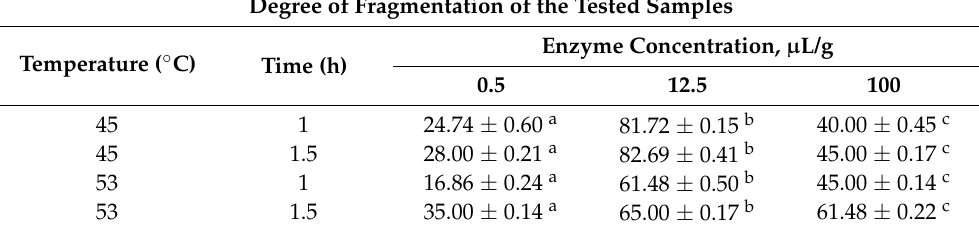
Table 1. Comparison procedures assuming equal variances by